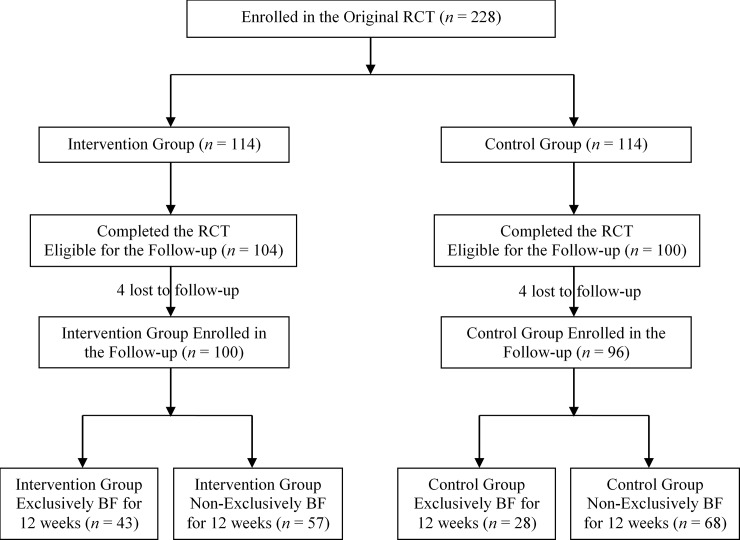
Study flow chart.RCT, randomized controlled trial; BF, breastfed.